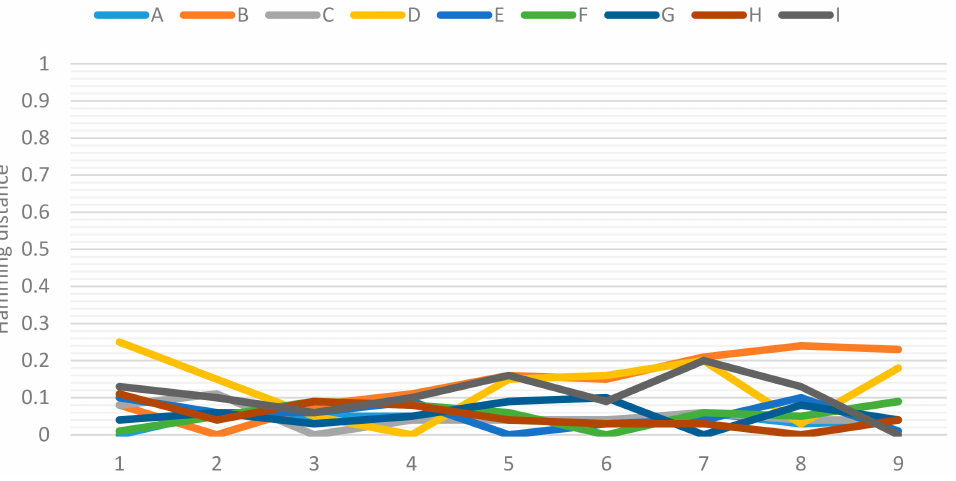
Figure 3. Hamming distance between experts in effect–effect relationships. Source: own